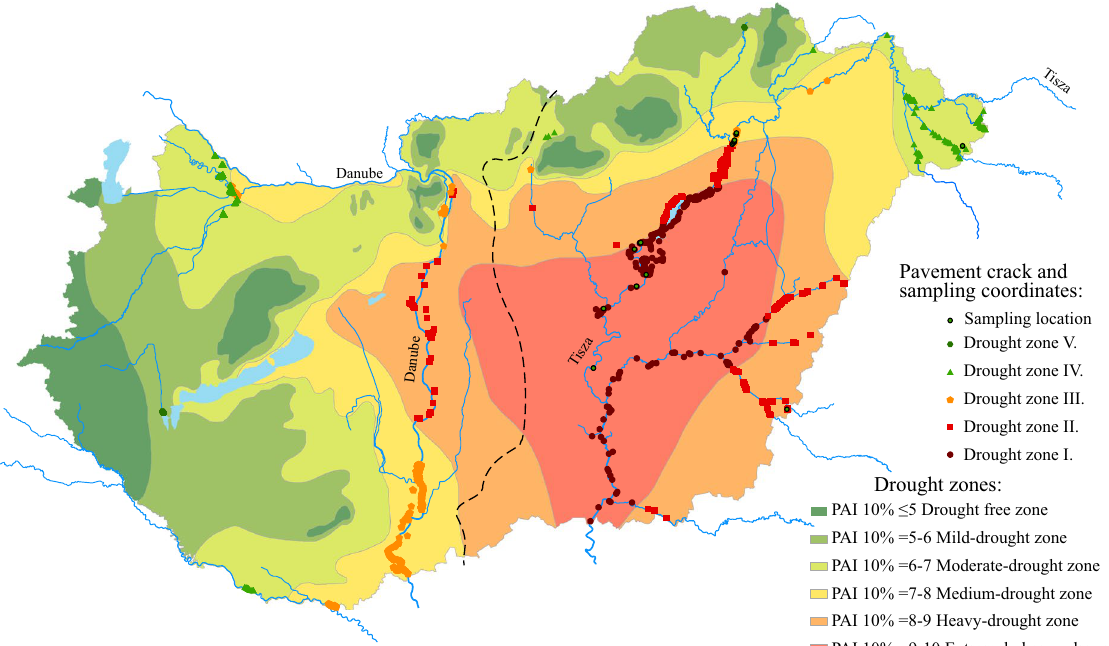
Fig. 13 Aridity map of Hungary (provided by OVF) and the coordinates of the pavement cracks